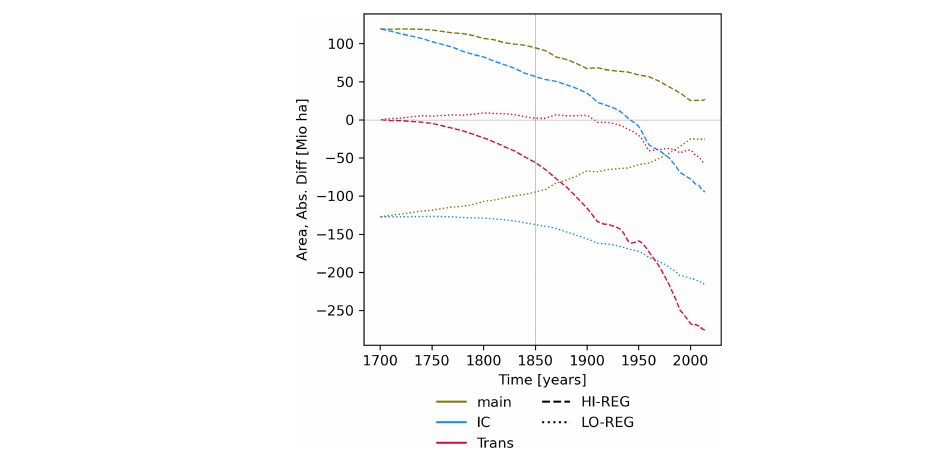
Figure A4. Differences in global total agricultural area in BLUE, also including results from initial condition (IC) and transition (Trans) sensitivity experiments (see Table 2).